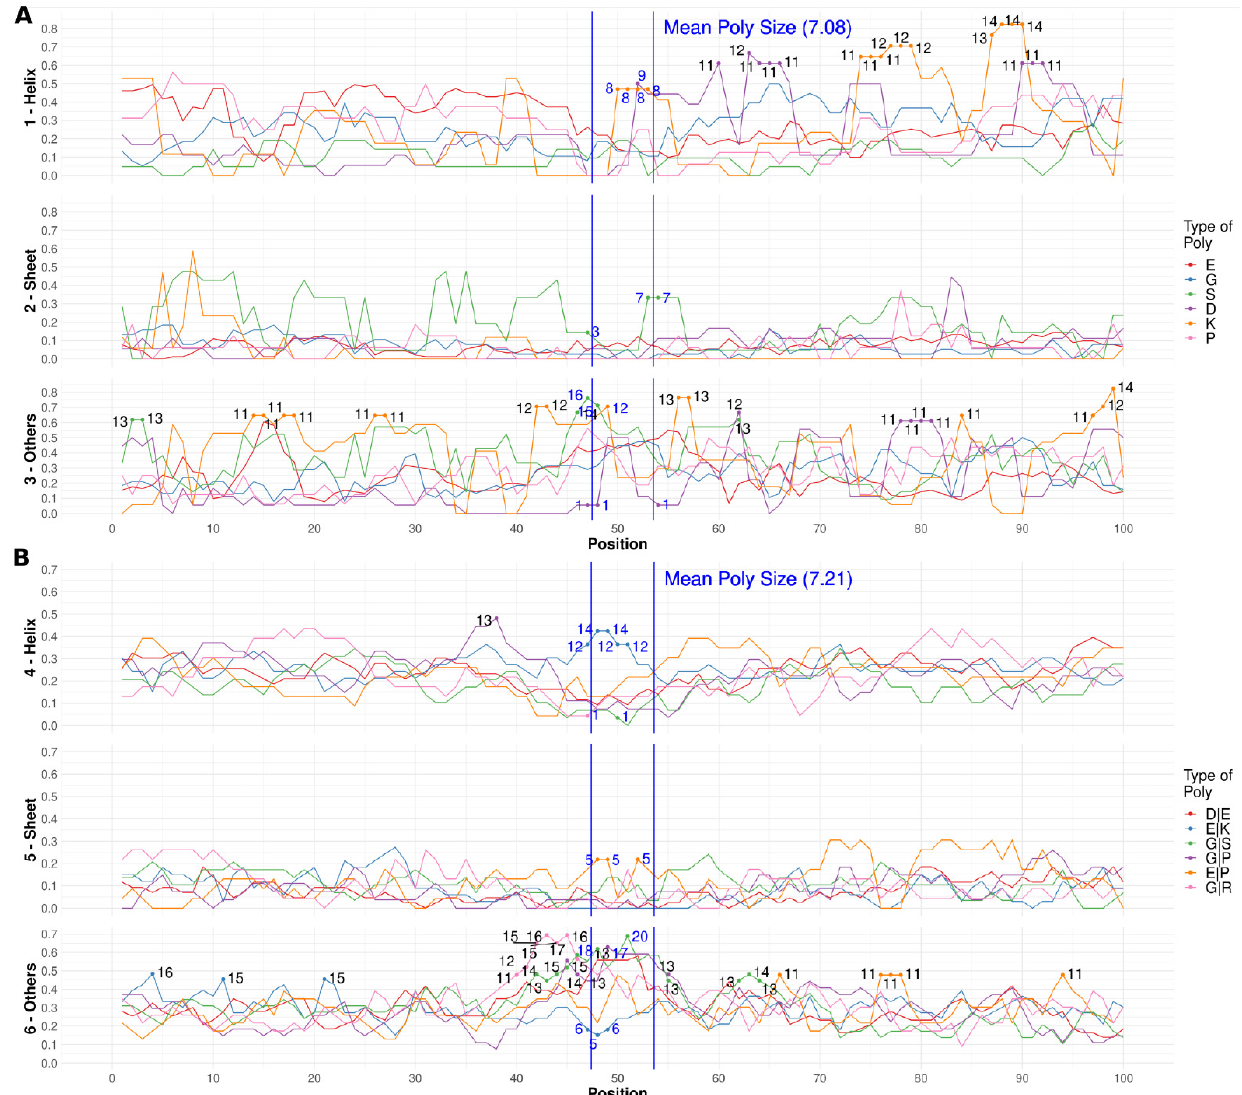
Figure 2. Secondary structure in PDB homologs for simple LCRs by type . For each of the six most frequent polyX/polyXY (see legend for type), in a region of 100 residues centered in the polyX/polyXY, fraction of residues in aligned PDB sequences adopting structure. ( A ) polyX (1–Helix, 2–Sheet and 3–Others). ( B ) polyXY (4–Helix, 5–Sheet and 6–Others). See the Methods and Materials for details. The numeric annotations indicate absolute count values at 2% and 98% percentiles to highlight the lower and higher values for each structure type. The blue vertical lines delimit the mean region where polyXs or polyXYs are located.